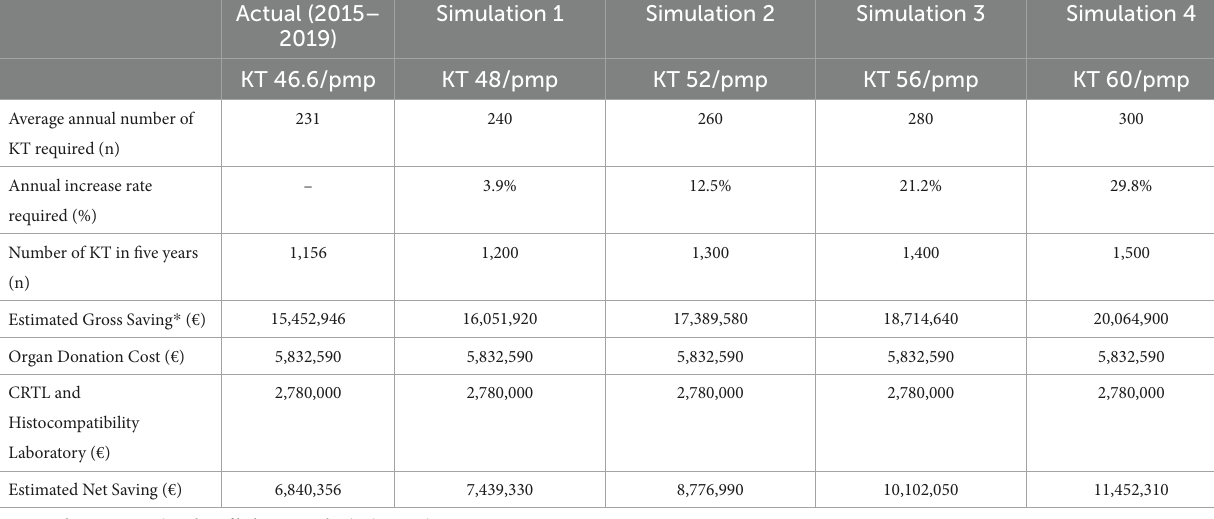
TABLE 4 Simulations of increased kidney transplantation activity with estimated gross and net